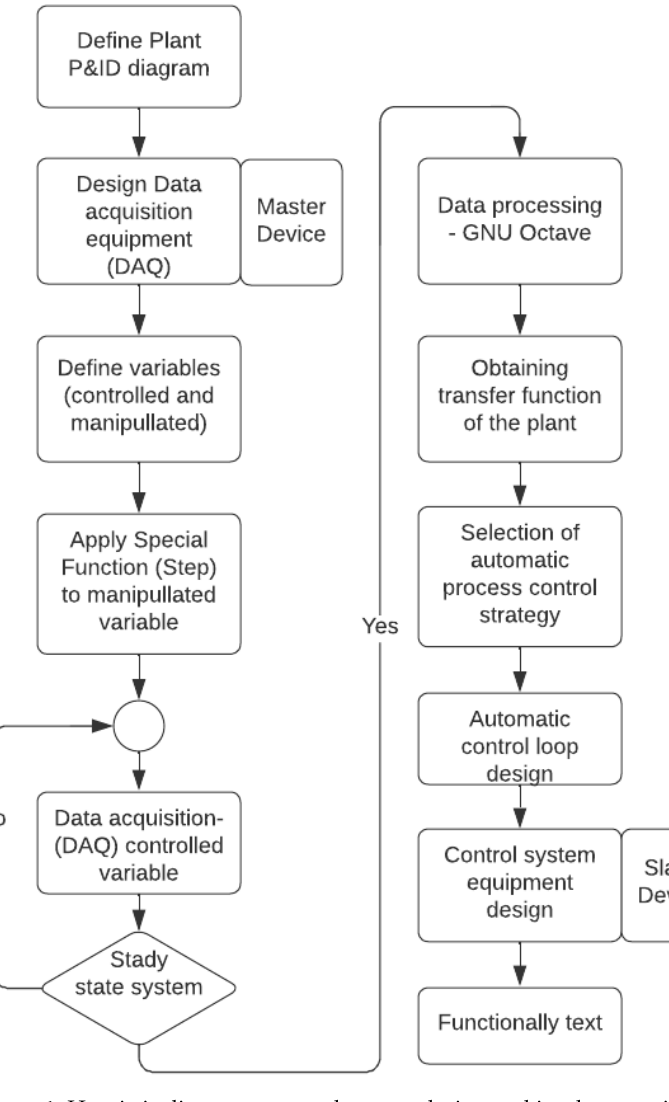
Figure 1. Heuristic diagram—control system design and implementation.